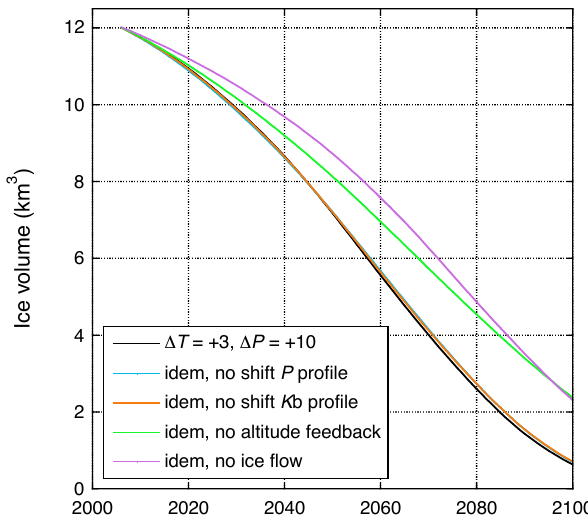
Fig. 14. Modelled ice cap volume from 2006 to 2100 for the cli- mate projection with 1T =+3 ◦ C and 1P =+10%, shown together with simulations without shifting the vertical precipitation and K b profiles, without the mass balance-altitude feedback and without ice